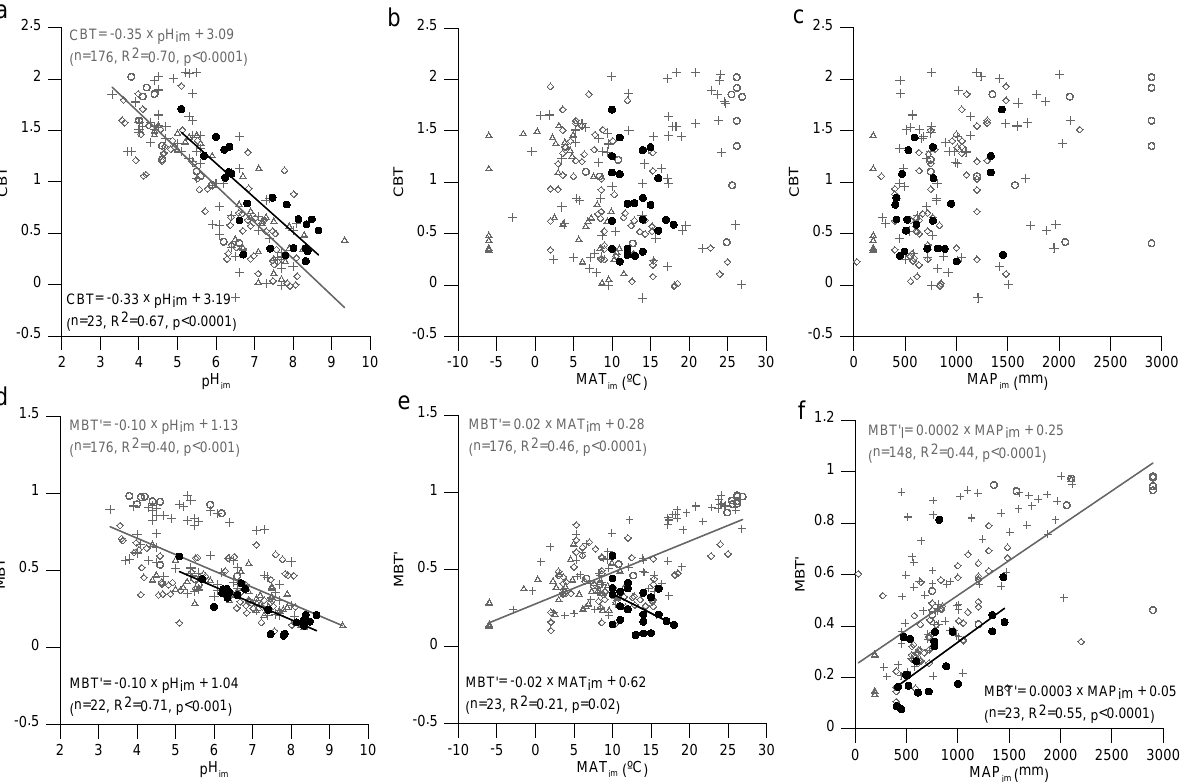
Fig. 2. Linear regression plots of (a) measured soil pH (pH im ) vs. CBT, (b) measured mean annual temperature (MAT im ; Ninyerola et al., 2005) vs. CBT, (c) Mean annual precipitation (MAP im ; Ninyerola et al., 2005) vs. CBT, (d) soil pH im vs. MBT’, (e) MAT im vs. MBT’, and (f) MAP im vs. MBT’. Data compiled by Peterse et al. (2012) are plotted in grey and distinguished by symbols as follows: Weijers et al. (2007) ( + ), Peterse et al. (2012) ( ♦ ), Bendle et al. (2010) ( (cid:13) ) and Peterse et al. (2009b) ( 1 ). Data from this study are shown as black circles ( • ). Linear regression lines, equations, R 2 , and p values are shown in grey for the Peterse et al. (2012) data set and in black for the present